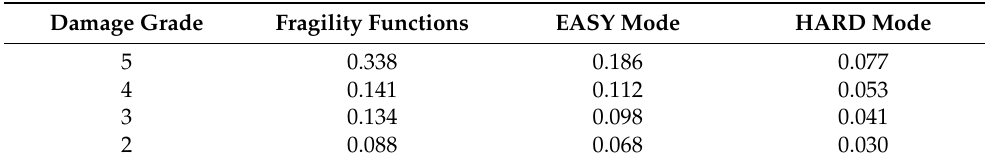
Table 6. Results comparison of fragility curves and assessment model in microzones where the stone masonry is the main building structure